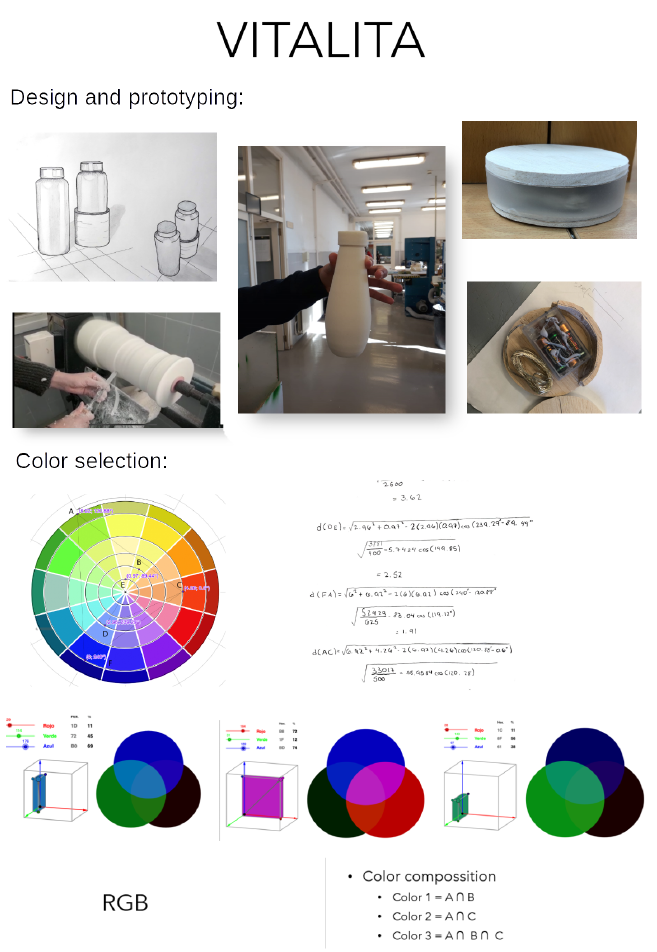
Figure A1. VITALIA. A bottle of water that it is able to measure the quantity of water that you drink in a day and alerts you when you should